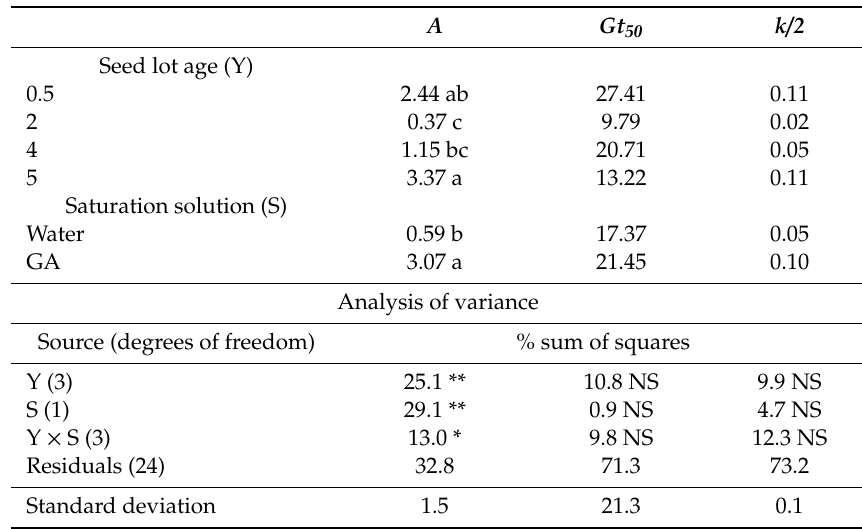
Table 2. E ff ects of the seed lot age (years) and the saturation solution on the germination parameters: Final germination percentage ( A , %), time (d) required to reach 50% of final germination ( Gt 5 0 ), and average germination rate ( k / 2 ; d − 1 ). Mean